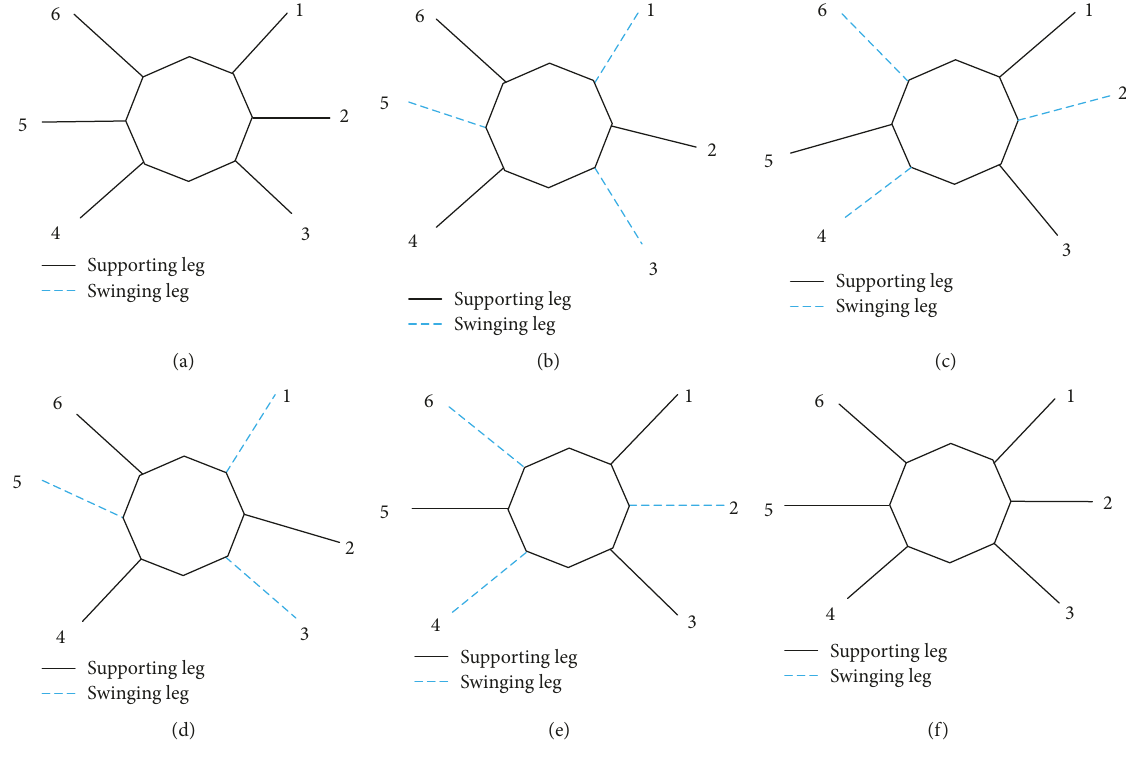
Figure 8: A general triangular gait of robot walks on the